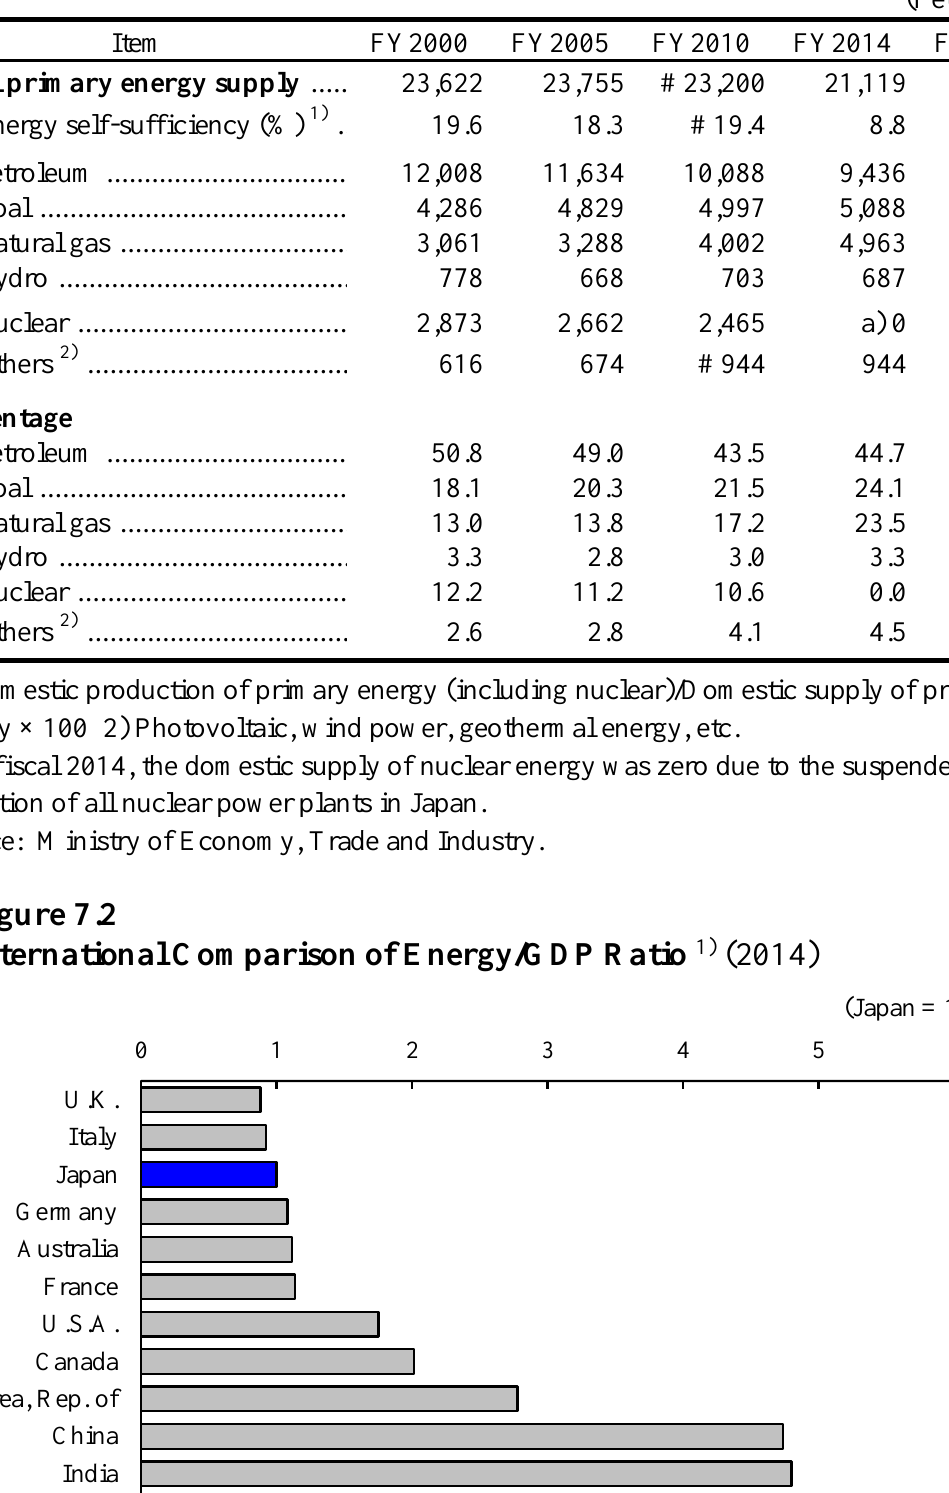
Table 7.1 Trends in Total Primary Energy Supply and Percentage by Energy Source